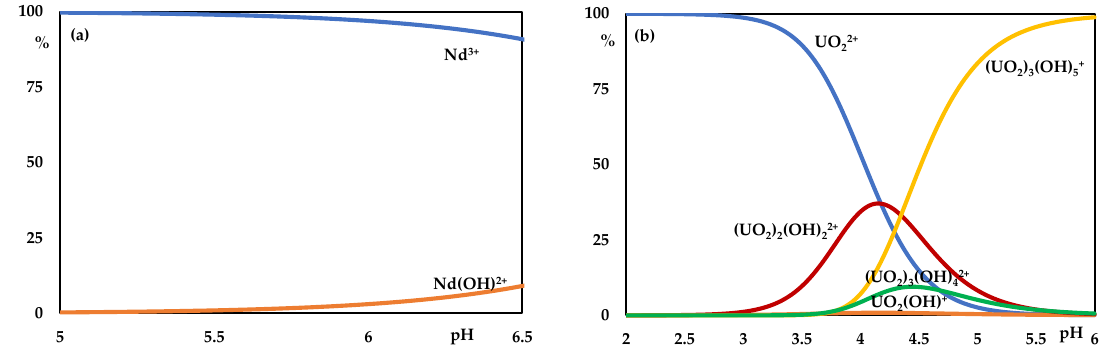
Figure 3. Distribution diagrams of hydrolytical species of ( a ) Nd 3+ ( C M = 1.0 mM) and ( b ) UO 22+ ( C M = 2.5 mM). The results obtained for the neodymium- and uranyl-HCCA systems are reported in Table 1. For the neodymium-HCCA system, experimental data were explained with the formation of one complex, and the best minimum was obtained with the Nd(OH)CCA + species. A substantial decrease in the square error sum U (66.85%) was obtained consid- ering also the presence of Nd(OH)(CCA) 2 . No other complexes improved the fit. Table 1. Formation of complexes of coumarin-3-carboxylic acid with Nd 3+ and UO 22+ according to Equation (2) . Values of log β in NaClO 4 0.16 mol/L at 37 °C were obtained by numerical procedure. Standard deviations are reported as 3σ.